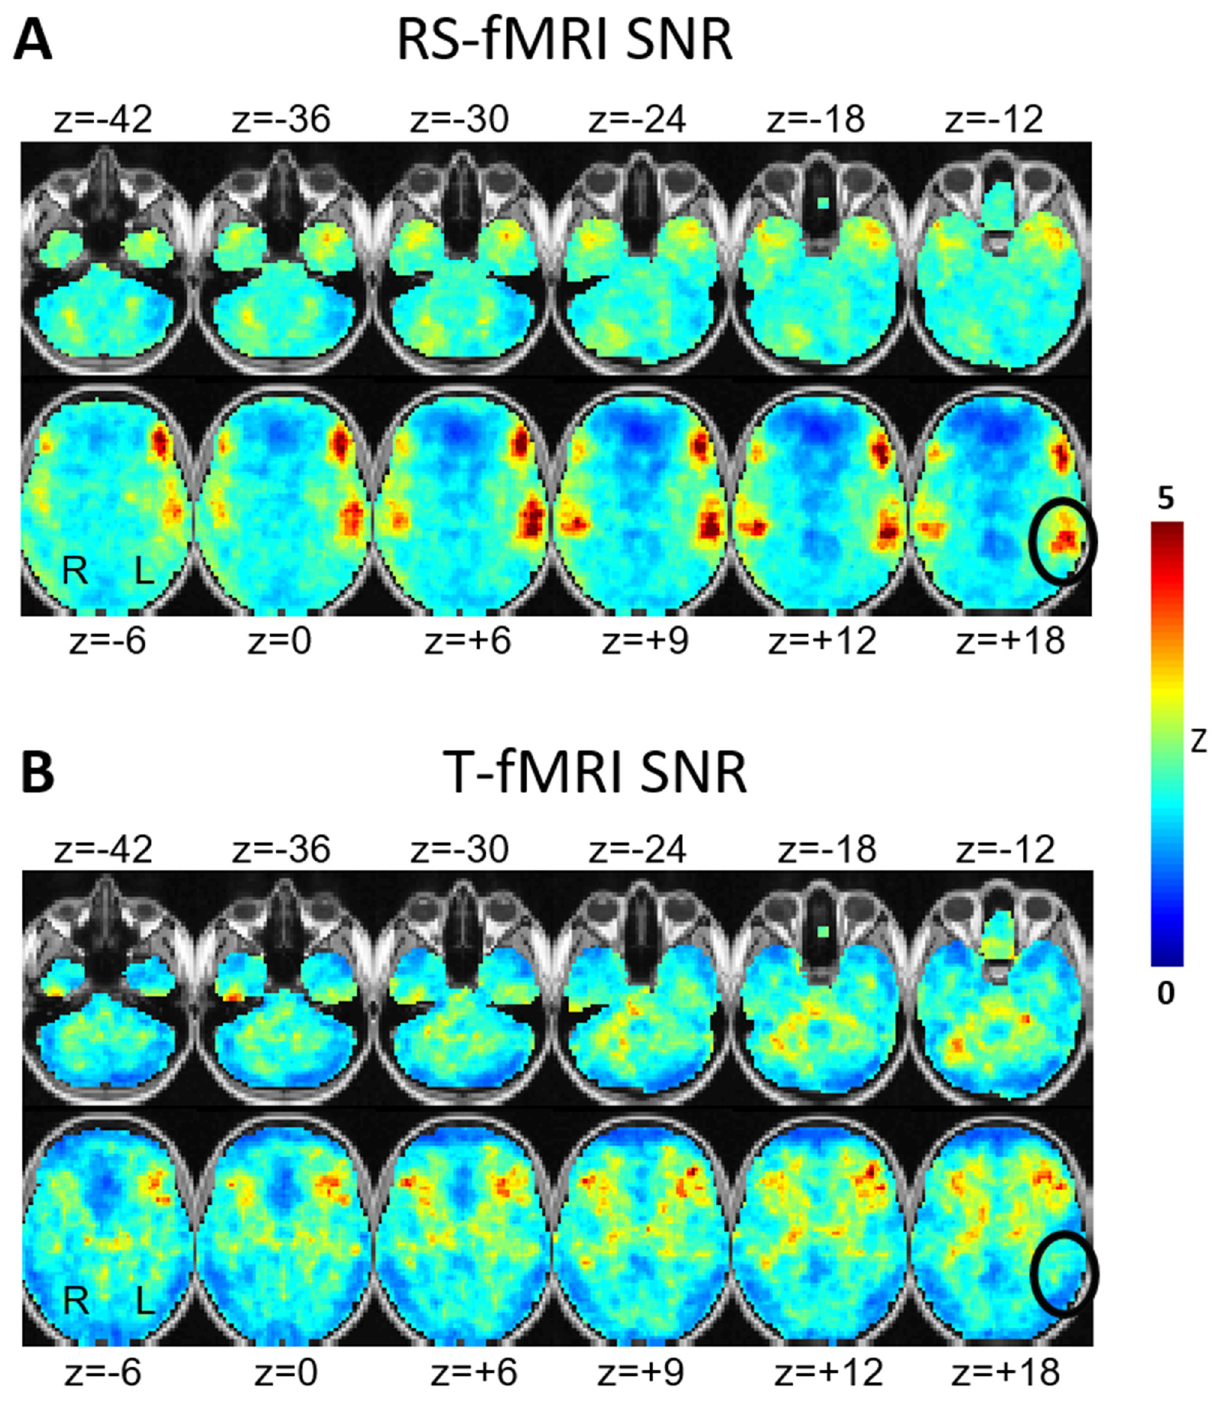
Fig 2. SNR maps. Task-based functional MRI and resting-state functional MRI SNR maps computed as signal-to-sampling variability ratio over individuals. High voxel values indicate consistency over subjects. (A) MLP-derived RS-MRI language RSN SNR. (B) Word-stem completion T-fMRI SNR. The black ovals indicate the same anatomic locus (Wernicke’s area) in both the MLP and T-fMRI SNR maps demonstrating markedly lower T- fMRI response consistency across individuals. The represented quantity is the voxel-wise Z-score, i.e., response mean divided by response standard